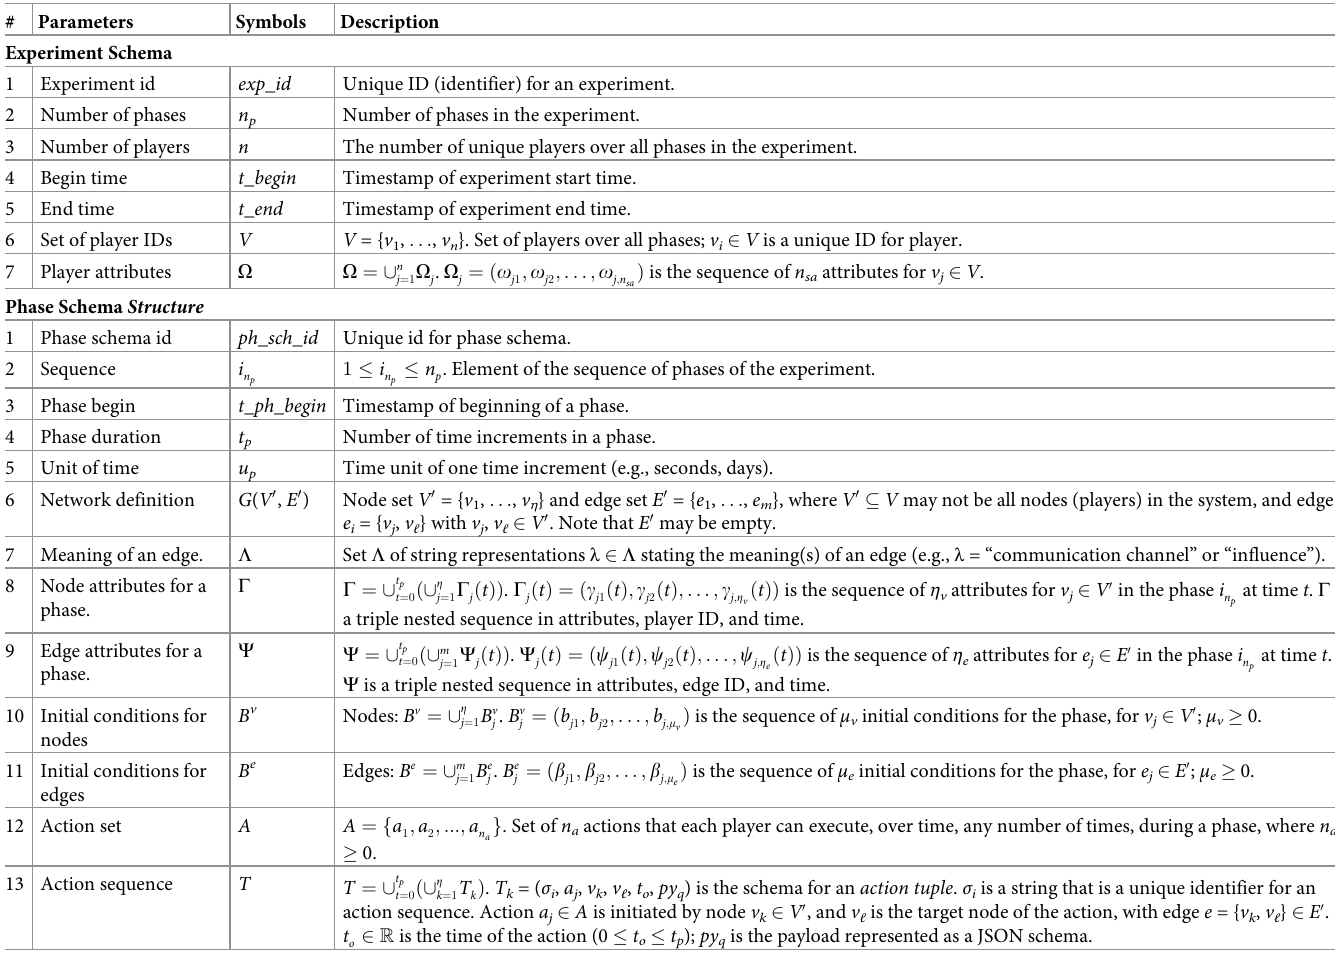
Table 3. Definition of our abstract data